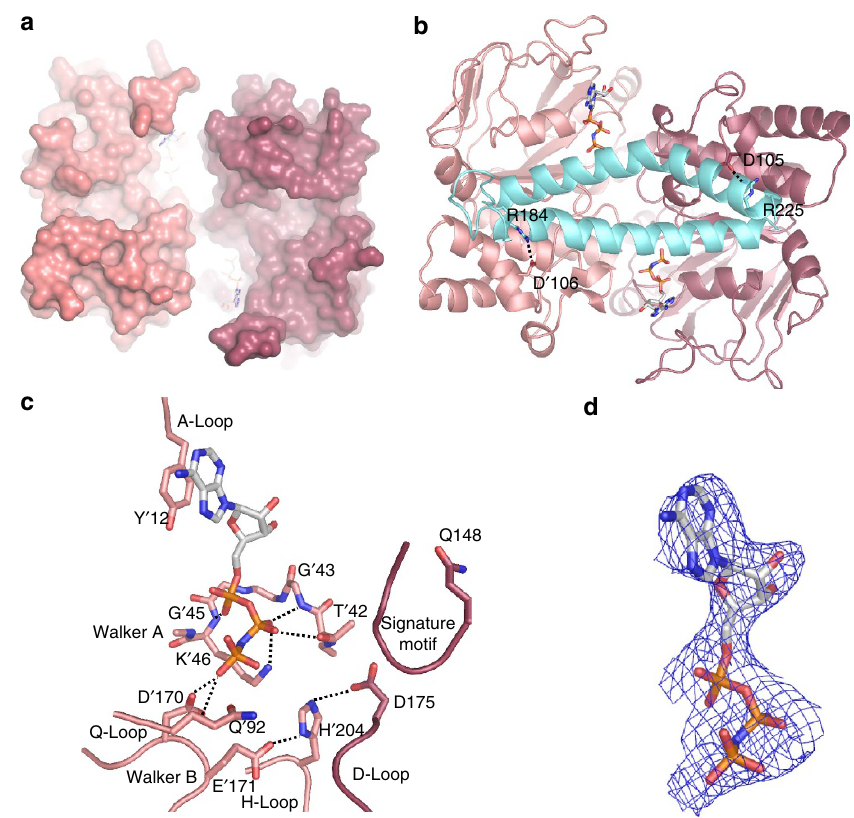
Figure 6 | AMP–PNP binding to the EcfAA 0 heterodimer. ( a ) Surface representation AMP–PNP-bound EcfAA 0 heterodimer coloured as in Fig. 3 with the AMP–PNP molecules in stick representation. The viewpoint is from the extracytoplasmic side ( b ) Cartoon representation of the AMP–PNP-bound EcfAA 0 heterodimer and the coupling helices CH2 and CH3 of EcfT. The conserved arginines at the C-terminal end of the coupling helices, and the interacting aspartates in the EcfAA 0 heterodimer are shown in sticks. The interactions are indicated by the dashed lines. ( c ) AMP–PNP-binding site on EcfA 0 (coloured light red). The conserved motifs found in ABC transporter ATPases are indicated. ( d ) 2Fo–Fc electron density at 2 s in blue contouring AMP–PNP (same viewpoint as in c